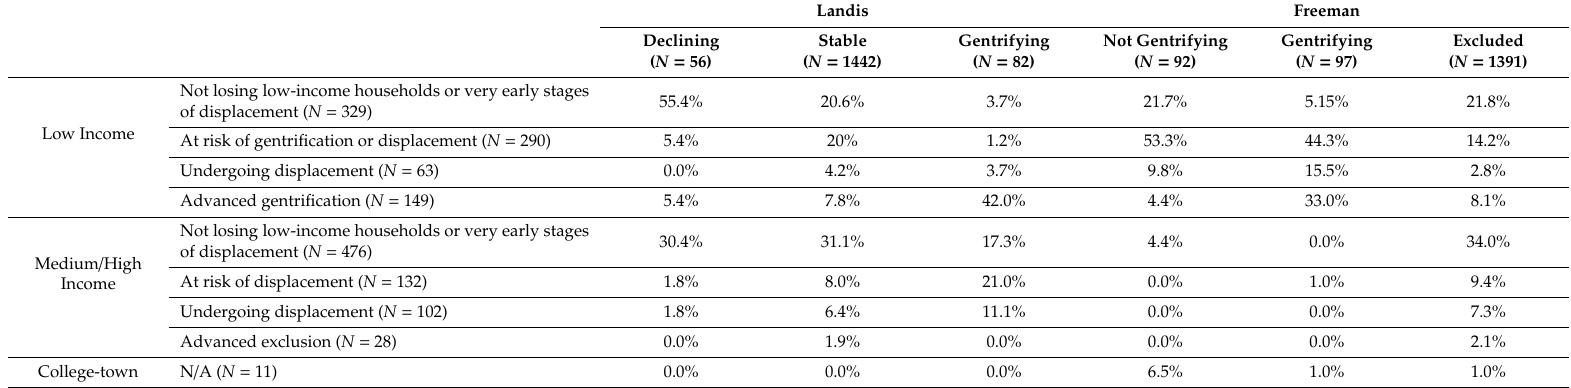
Table 4. The comparison of the three gentrification measures in the San Francisco Bay Area: Urban Displacement Project, Landis, and Freeman,